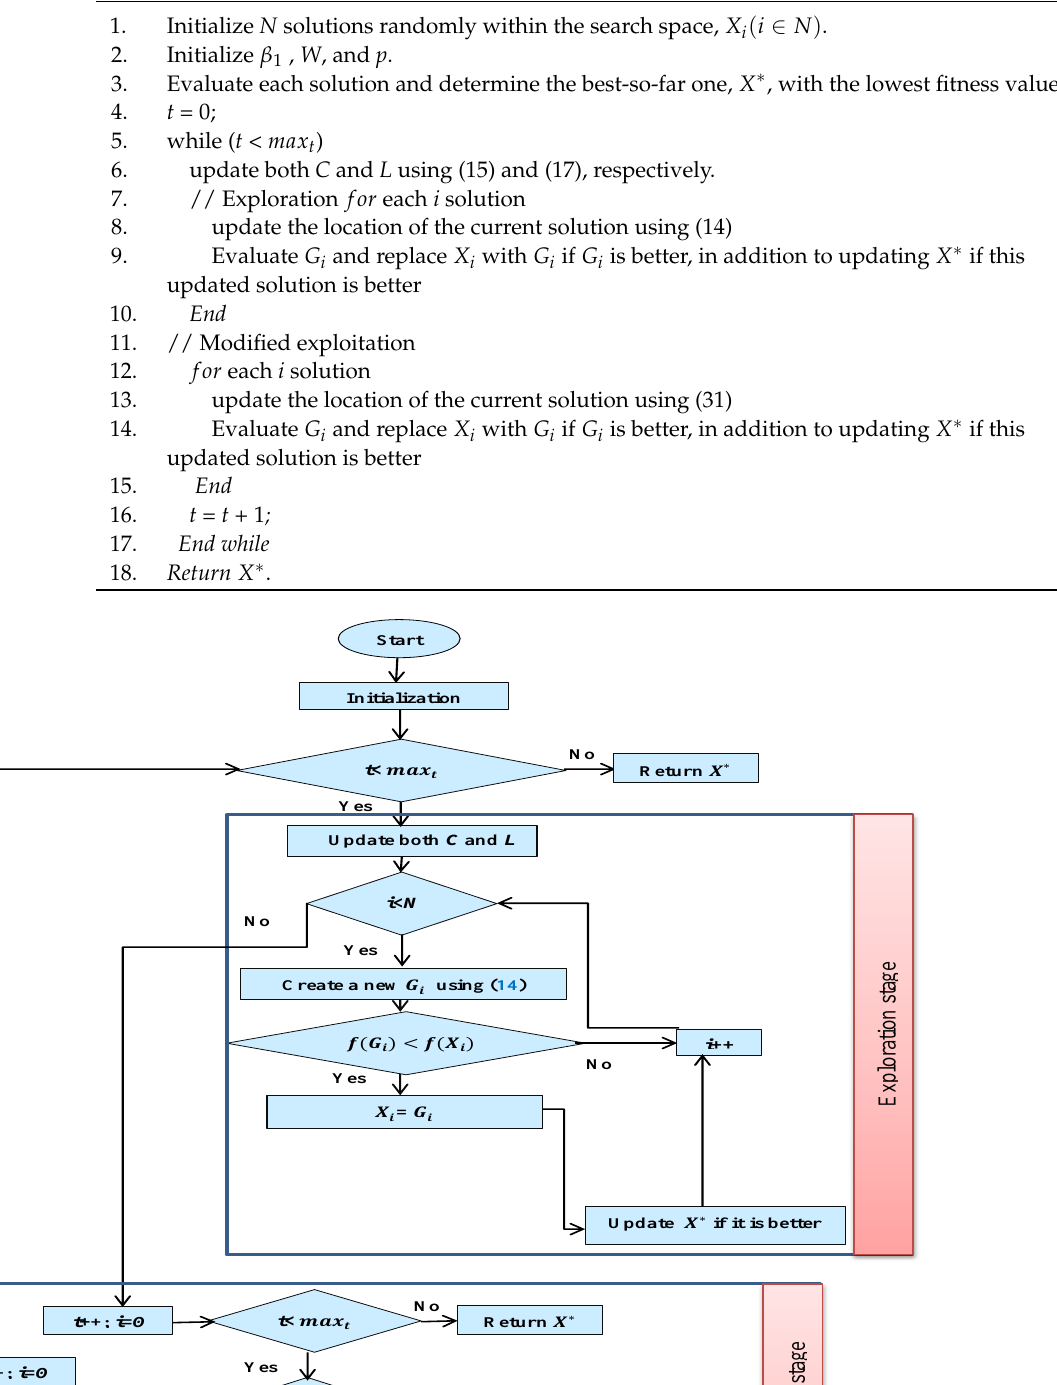
Algorithm 2 Pseudocode for modified GTO (MGTO)